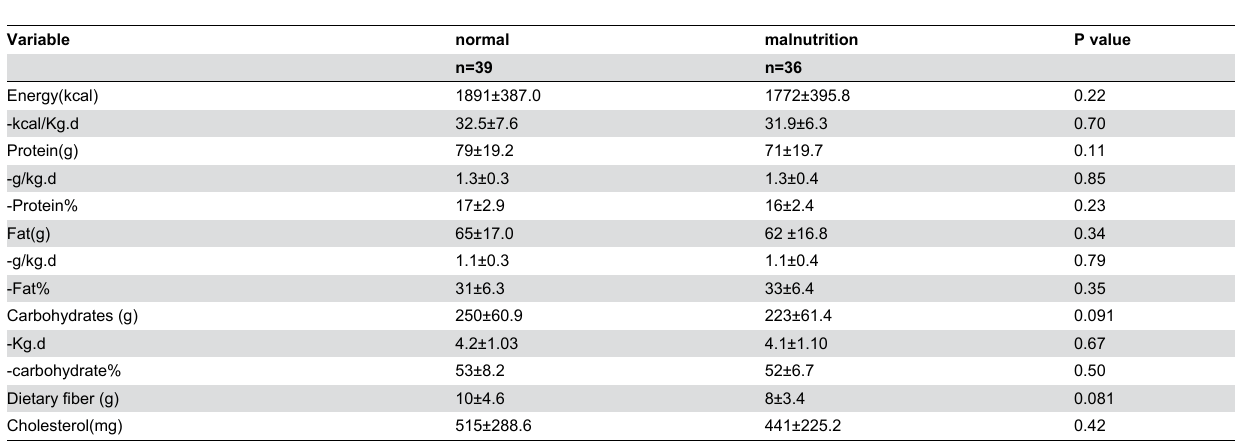
Table 2. Comparison of dietary macronutrients in different nutrition groups according to MIS in hemodialysis patients.